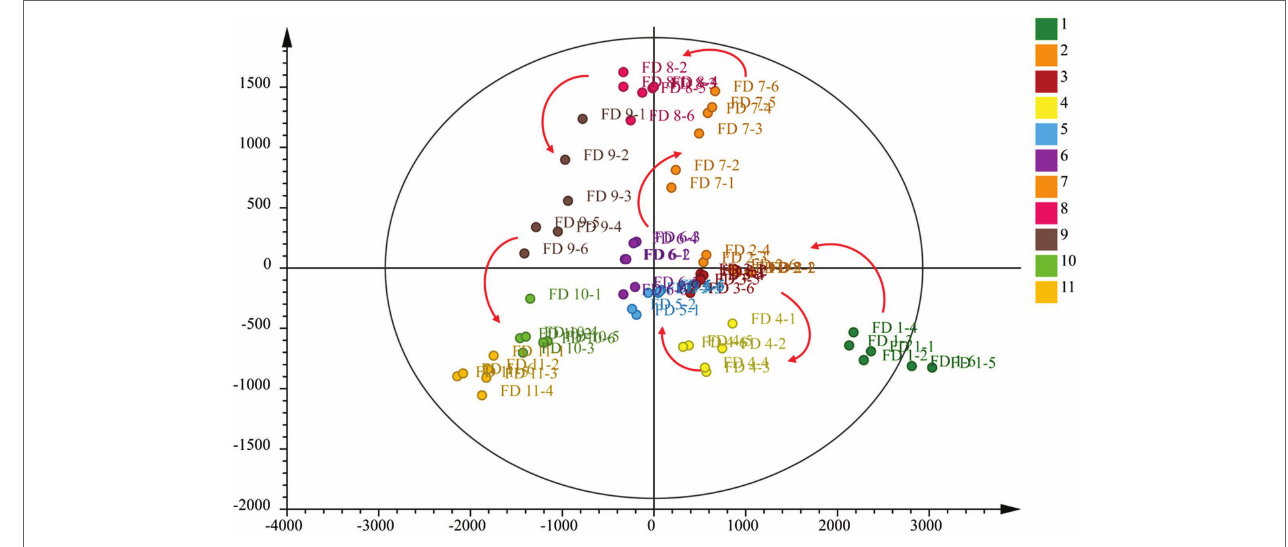
FIGURE 6 | Principal component analysis of CWT at different growth stage in negative ion mode.